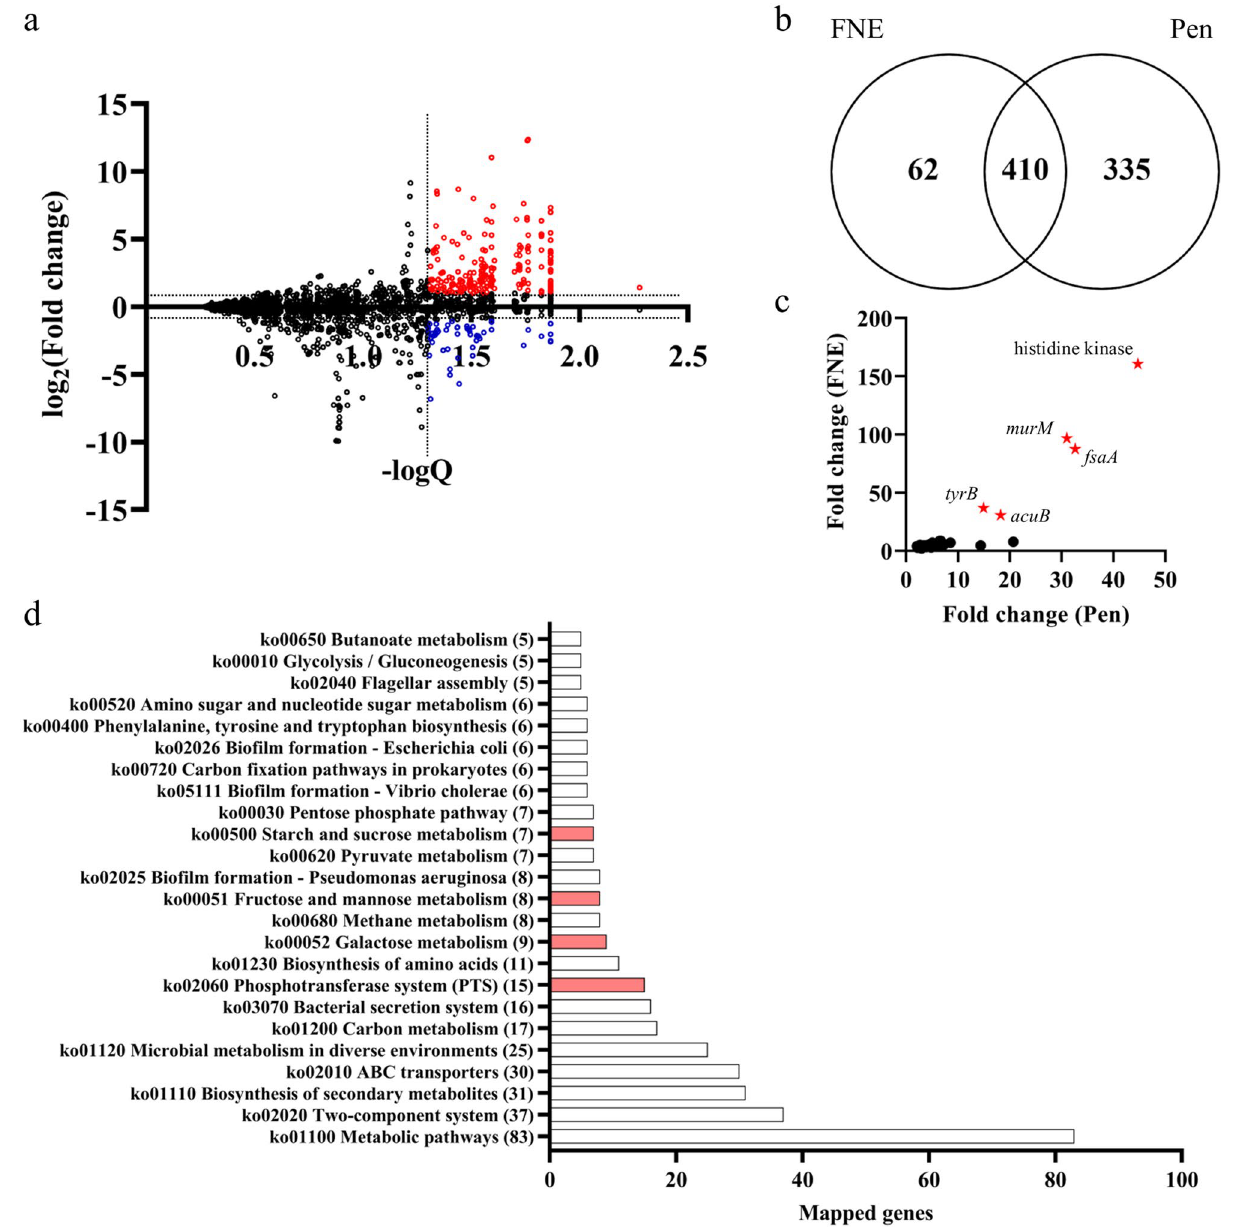
Figure 6. Differential predictive metagenome composition of the fecal microbiota. (a) Overall distribution of the predictive metagenome composition. The fold change (PS150/control) of predicted gene copy numbers from the cage change group was plotted against statistical significance (Q value). Significantly enriched and reduced genes in the PS150 group are colored red and blue, respectively. (b) Venn diagram of significantly enriched genes from this study (FNE) and our previous pentobarbital-induced sleep model (Pen). (c) Abundant genes enriched in the microbiota of the PS150 group from both mouse models. Only genes with an estimated composition > 100 ppm of the metagenome were plotted. The top five coenriched genes are labeled with a red star, including histidine kinase, serine/alanine adding enzyme ( murM ), fructose-6-phosphate aldolase 1 ( fsaA ), aromatic-amino-acid transaminase ( tyrB ), and acetoin utilization protein ( acuB ). (d) Pathway mapping of the 410 coenriched genes from both models using the Kyoto Encyclopedia of Genes and Genomes (KEGG) database. Phosphotransferase (PTS) systems and the related carbohydrate metabolic pathways are colored